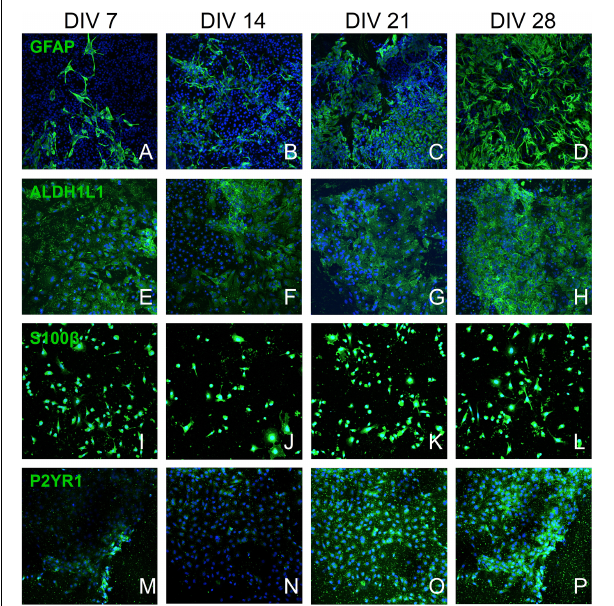
FIGURE 2 | Confocal culture micrographs (7–28 DIV) of astrocytes inducted from mESC, immunofluorescently labeled for established astrocytic markers: (A–D) – GFAP, (E–H) – ALDH1L1, (I–L) – S100B, and (M–P) – P2Y 1 R. Cell nuclei marker H-33342 (blue stain). Scale bar 20 µ m.